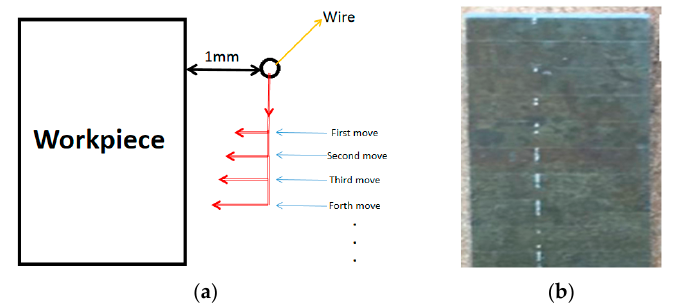
Figure 1. ( a ) Top view of the experimental principle; ( b ) single craters on part surface.